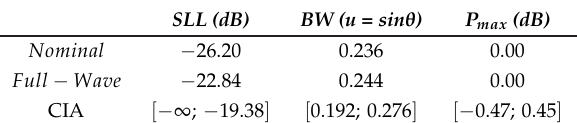
Table 4. Full-Wave Simulation ( N = 6, d = 0.8 λ ; Dolph–Chebyshev pattern: SLL ref = − 30 dB)—Pattern features of the nominal power pattern and FEKO-computed along with bounds of the interval power pattern features predicted with the CIA.